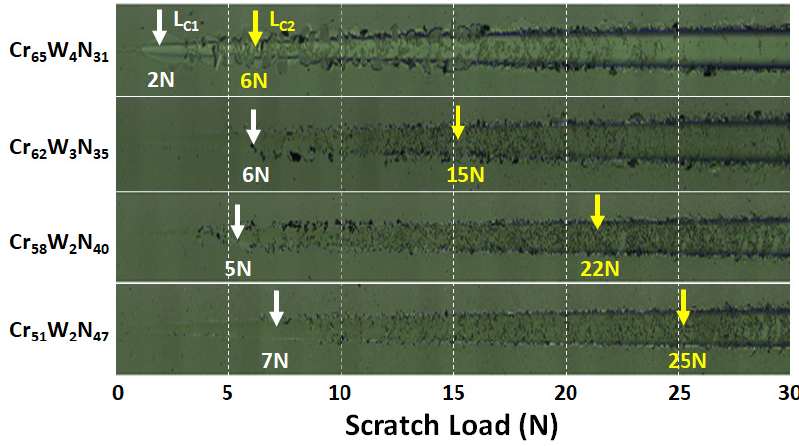
Figure 10. Scratch scars of the CrWN coatings.